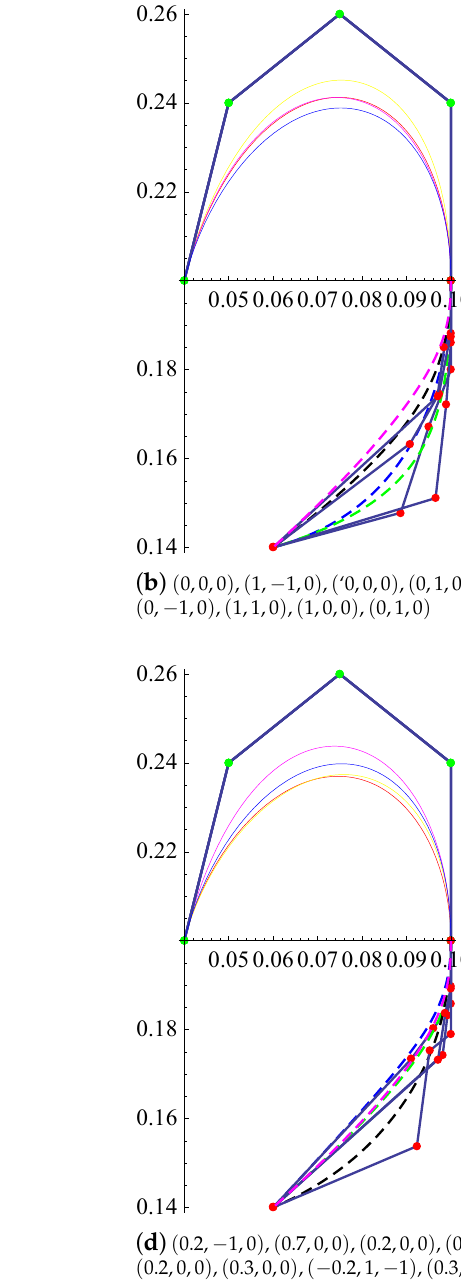
Figure 10. G 3 smooth continuity of the GHT-Bézier curve with multiple shape parameters. ( a ) ( 0,0,0 ) , ( 0,0,0 ) , ( 0,0,0 ) , ( 0,0,0 ) : ( 0,0.5,0 ) , ( 1, ( ‘0,0,0 ) , ( 0,1,0 )